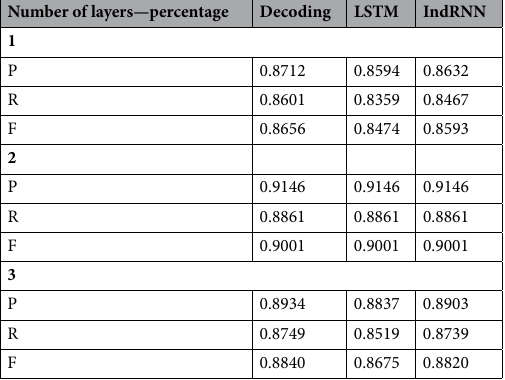
Table 2. Effect of the number of coding and decoding layers on the evaluation criteria values.